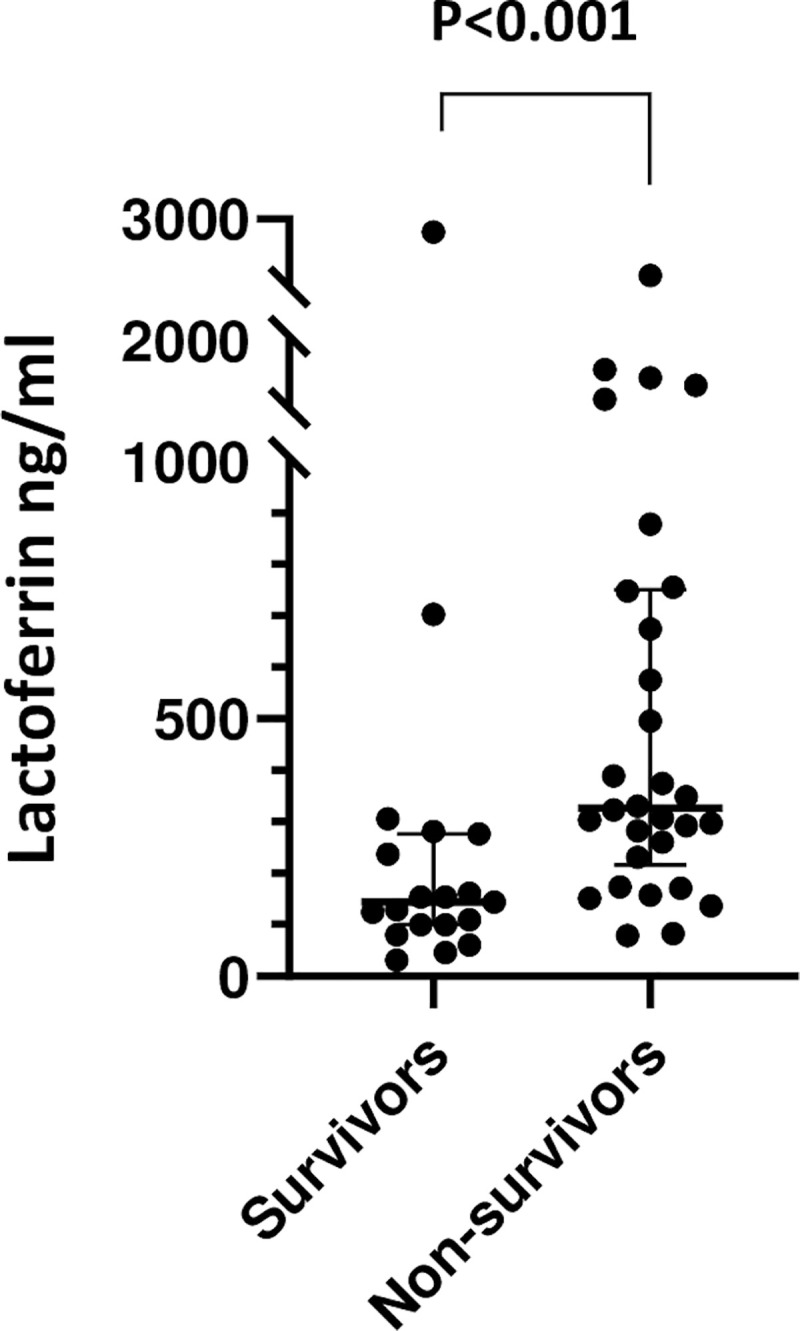
Plasma lactoferrin concentrations are higher in patients who do not survive melioidosis.Plasma lactoferrin concentrations, obtained at study enrollment, in survivors (N = 19) compared to 28-day non-survivors (30) of melioidosis. Data presented as individual values with median and IQR. Comparisons are made following log10-transformation of data using unpaired t-test.